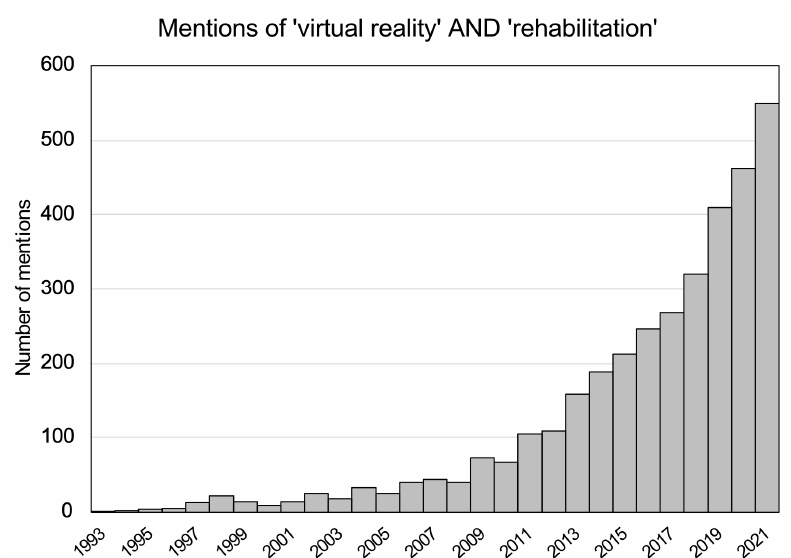
Figure 1. Number of mentions of ‘virtual reality’ and ‘rehabilitation’ in Medline (by 15 October 2022).